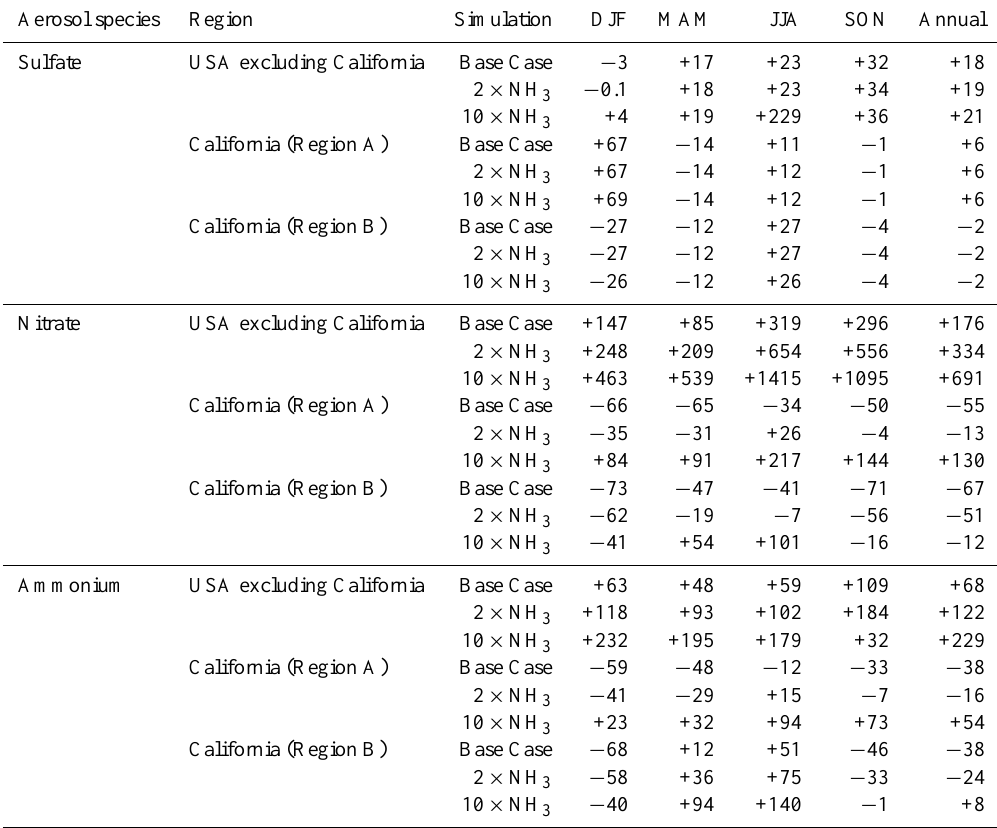
Table 2. Normalized mean bias (%) of predicted 2009 seasonal concentrations relative to measurements (IMPROVE, CASTNET, CARB), for the base case GEOS-Chem simulation and the two ammonia sensitivity simulations (2 × NH 3 and 10 × NH 3 ). Results for California are presented separately for the two regions shown in Fig.